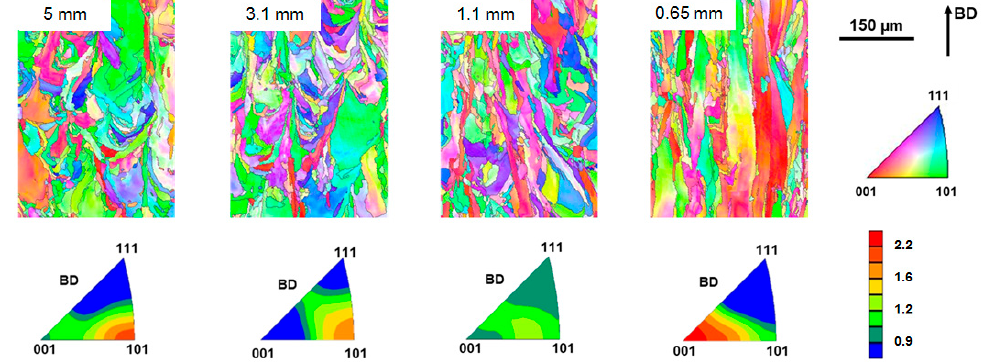
Figure 5. EBSD IPF maps and corresponding IPF intensity plots for BD for 316L steel specimens, recompiled from [38].